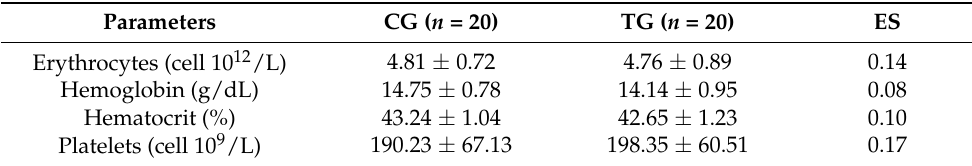
Table 4. Erythrocyte, hemoglobin, hematocrit and platelet values.